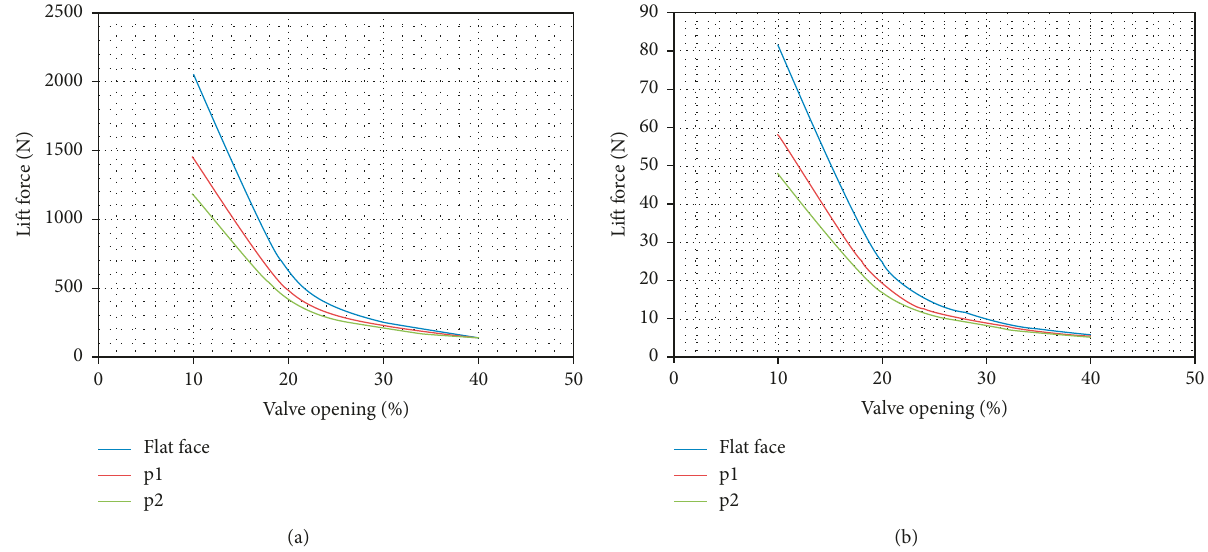
Figure 16: Relation between lift force acting on different plug geometries and percentage valve opening at v � 1m/s (a) and 5m/s